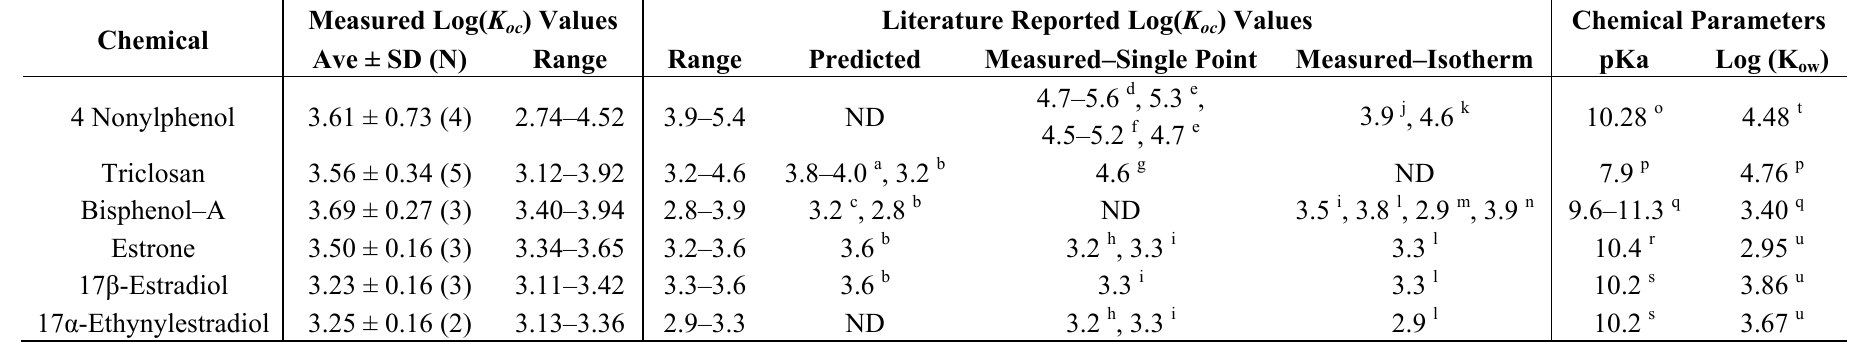
Table 3. K values from isotherm experiments with R 2 greater than 0.8 presented in this study compared with K oc literature. Chemical parameters, pKa and log( K ) are also listed for analytes. ND designates a value for which no data was reported. ow